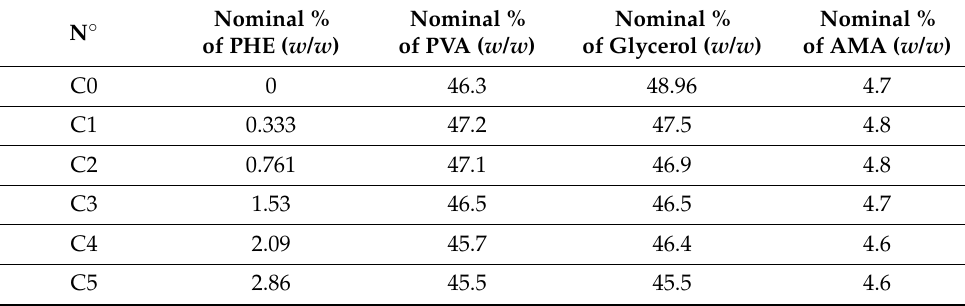
Table 2. Concentration of PHE, PVA, Glycerol and AMA in dried film (% w / w